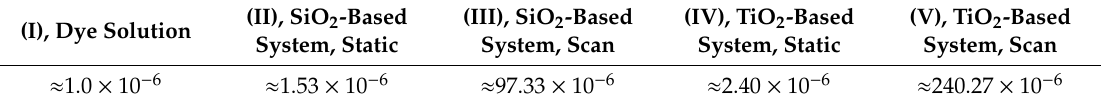
(cid:68) (cid:69) I 3 / (cid:104) I (cid:105) 3 , nm − 1 . (V), TiO 2 -Based System, Scan